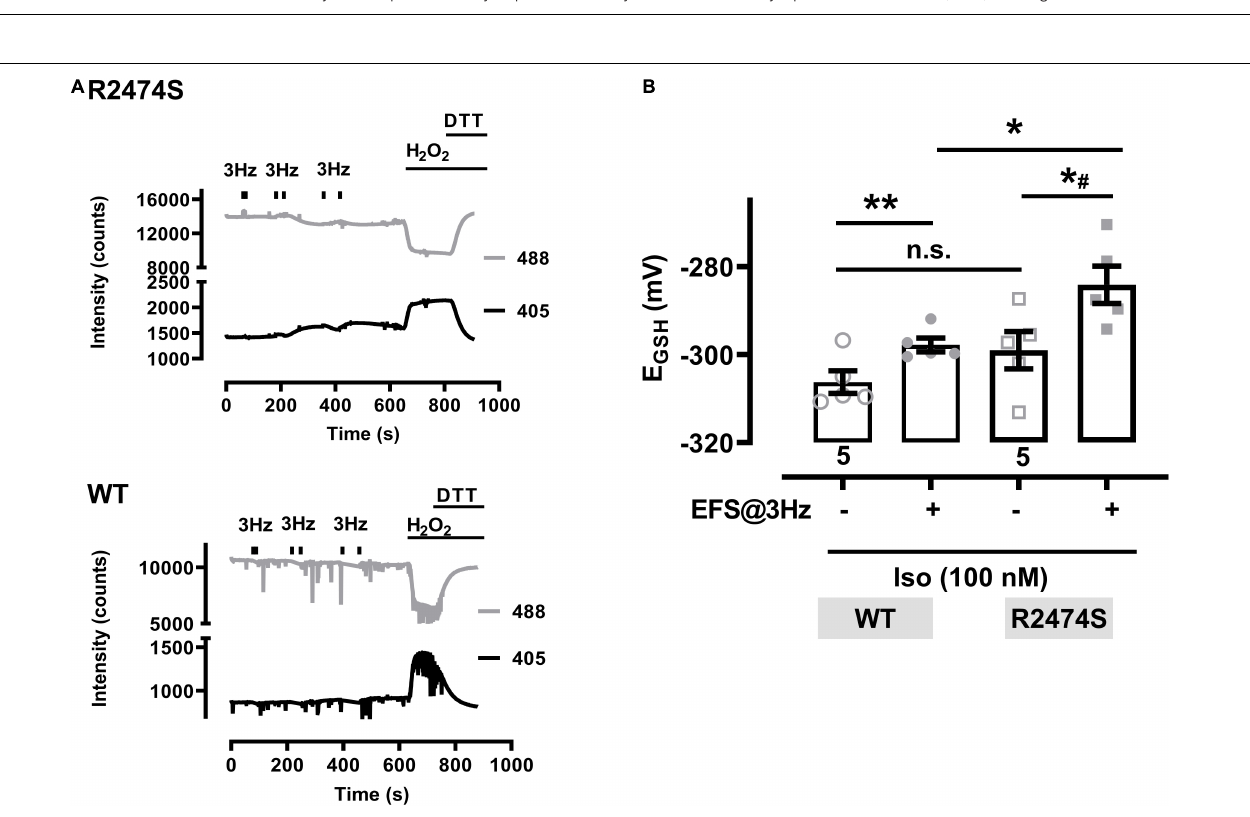
FIGURE 8 | Glutathione redox potentials (E GSH ) in cardiomyocytes from RyR2-WT control and RyR2-R2474S dTG mice. (A) Representative trace of the emitted fluorescent intensity signals at 405 and 488 nm excitation in a cardiomyocyte from a RyR2-R2474S dTG mouse (above) and a WT control mouse (below) in the presence of isoproterenol (100 nM). Bars indicate the start and stop of contractile activity induced by EFS at 3 Hz. H 2 O 2 (200 µ M) followed by DTT (1 mM) were applied at the end of the experiment to obtain the maximal and minimal signal values, respectively. (B) Calculated E GSH before and after contractile activity induced by EFS-pacing (3 Hz, 60 s, time point at 600 s) in the presence of isoproterenol (100 nM) in cardiomyocytes from RyR2-WT control and RyR2-R2474S dTG mice. Numbers indicate the number of cells used (five cells from two mice, each). Statistical analysis was performed by a paired (control vs. isoproterenol) or unpaired (RyR2-WT control vs. RyR2-R2474S dTG) Student’s t -test. ** P = 0.001; * P = 0.02; * # P = 0.01; n.s., non-significant.